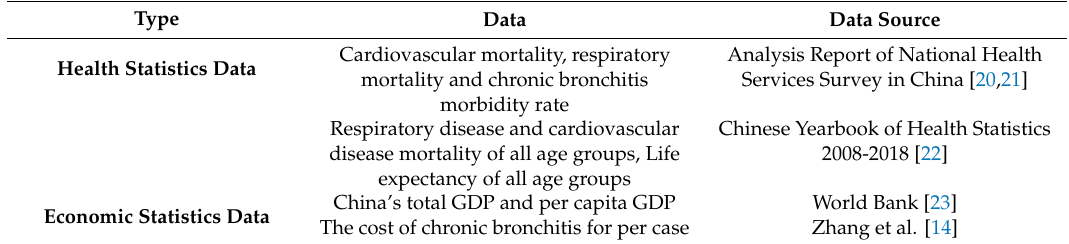
Table 2. The data source of statistics data applied in this